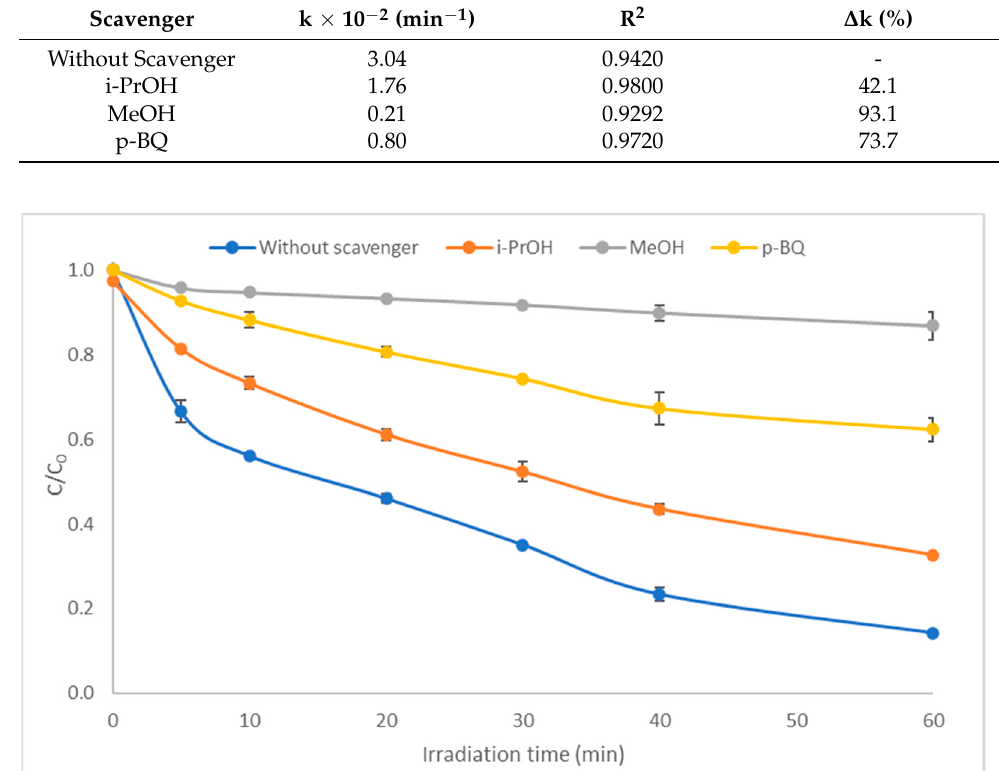
Figure 3. Photocatalytic degradation of amisulpride in the presence of scavengers ([amisulpride] 0 = 1 mg L − 1 ; [g-C 3 N 4 ] = 300 mg L − 1 ; [i-PrOH] = 0.1 M; [MeOH]= 0.1 M; [p-BQ] = 0.2 mM, matrix: UW).